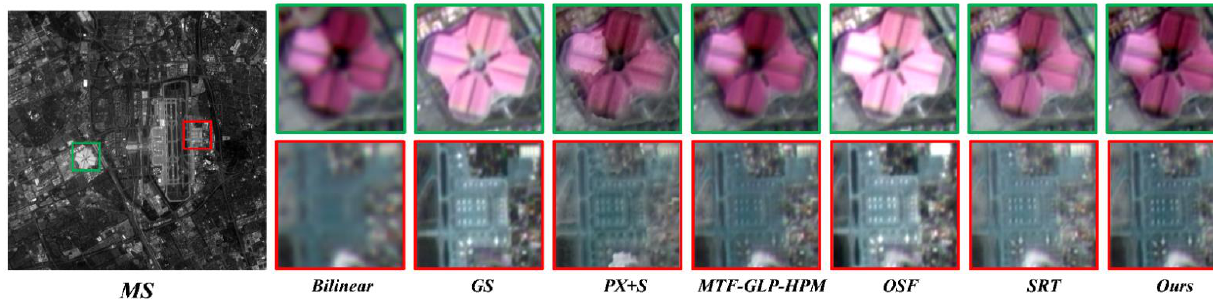
Figure 9. The results of different fusion methods for Shanghai Hongqiao Airport are shown.